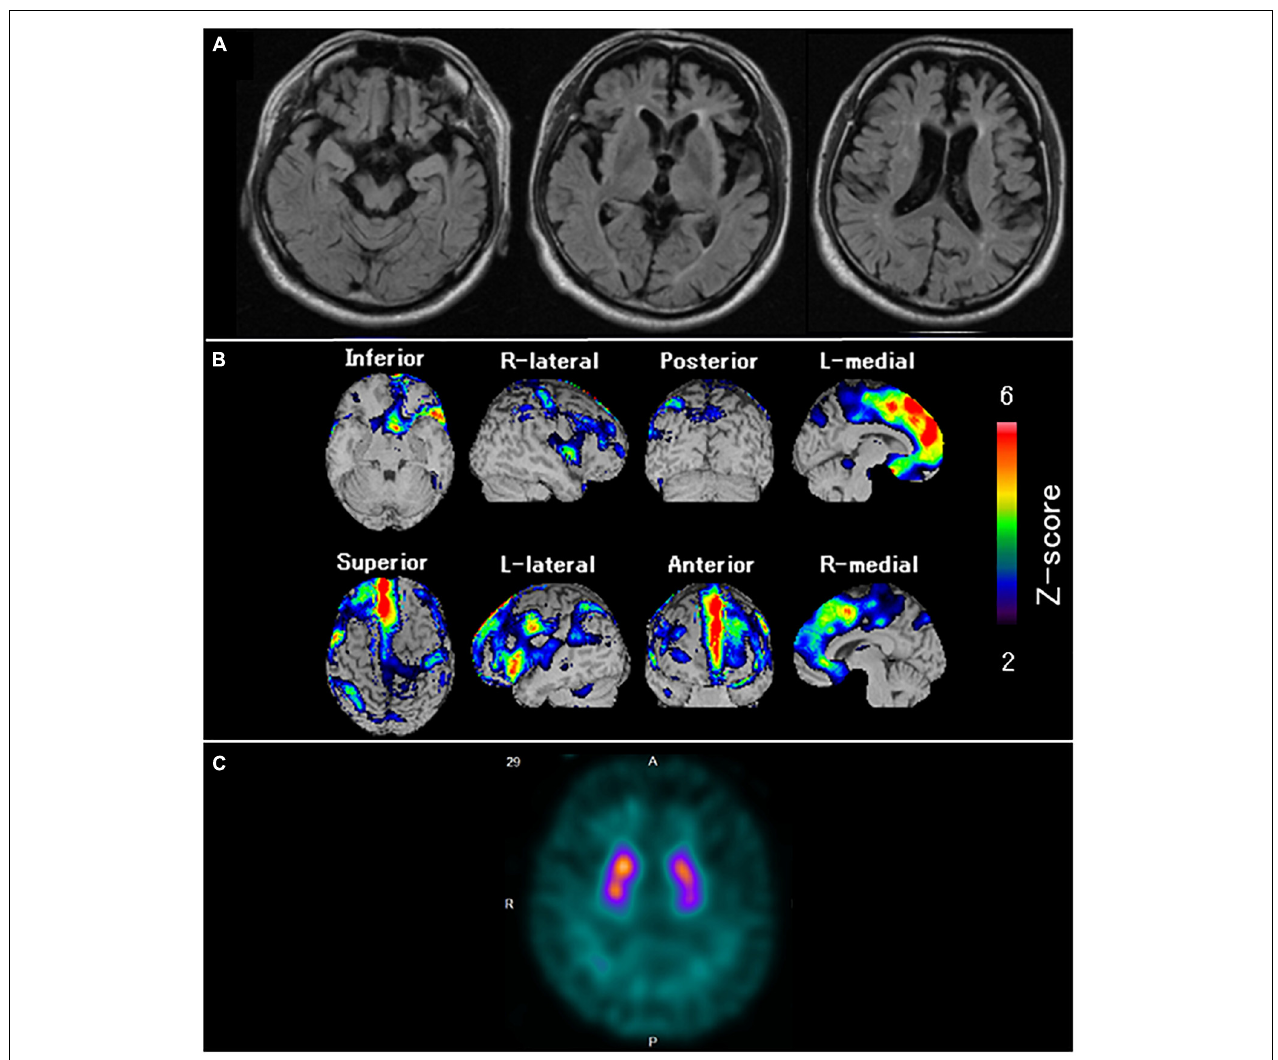
FIGURE 6 | Neuroradiological findings in Case 4. (A) Magnetic resonance imaging shows marked bilateral frontal lobe atrophy, predominant on the left side. (B) Brain perfusion single photon emission computed tomography (SPECT) easy Z-score Imaging System analysis (FUJIFILM Toyama Chemical Co., Ltd., Tokyo, Japan) shows significant bilateral medial frontal lobe hypoperfusion. The color scale for the Z-score is shown on the right side of the figure. Presented in color if the Z-score was > 2. (C) Dopamine transporter (DAT) SPECT shows reduced DAT availability in the bilateral striatum, predominant on the left